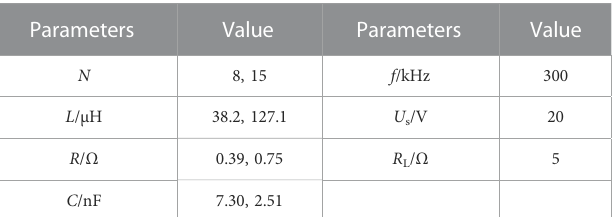
TABLE 4 Actual circuit